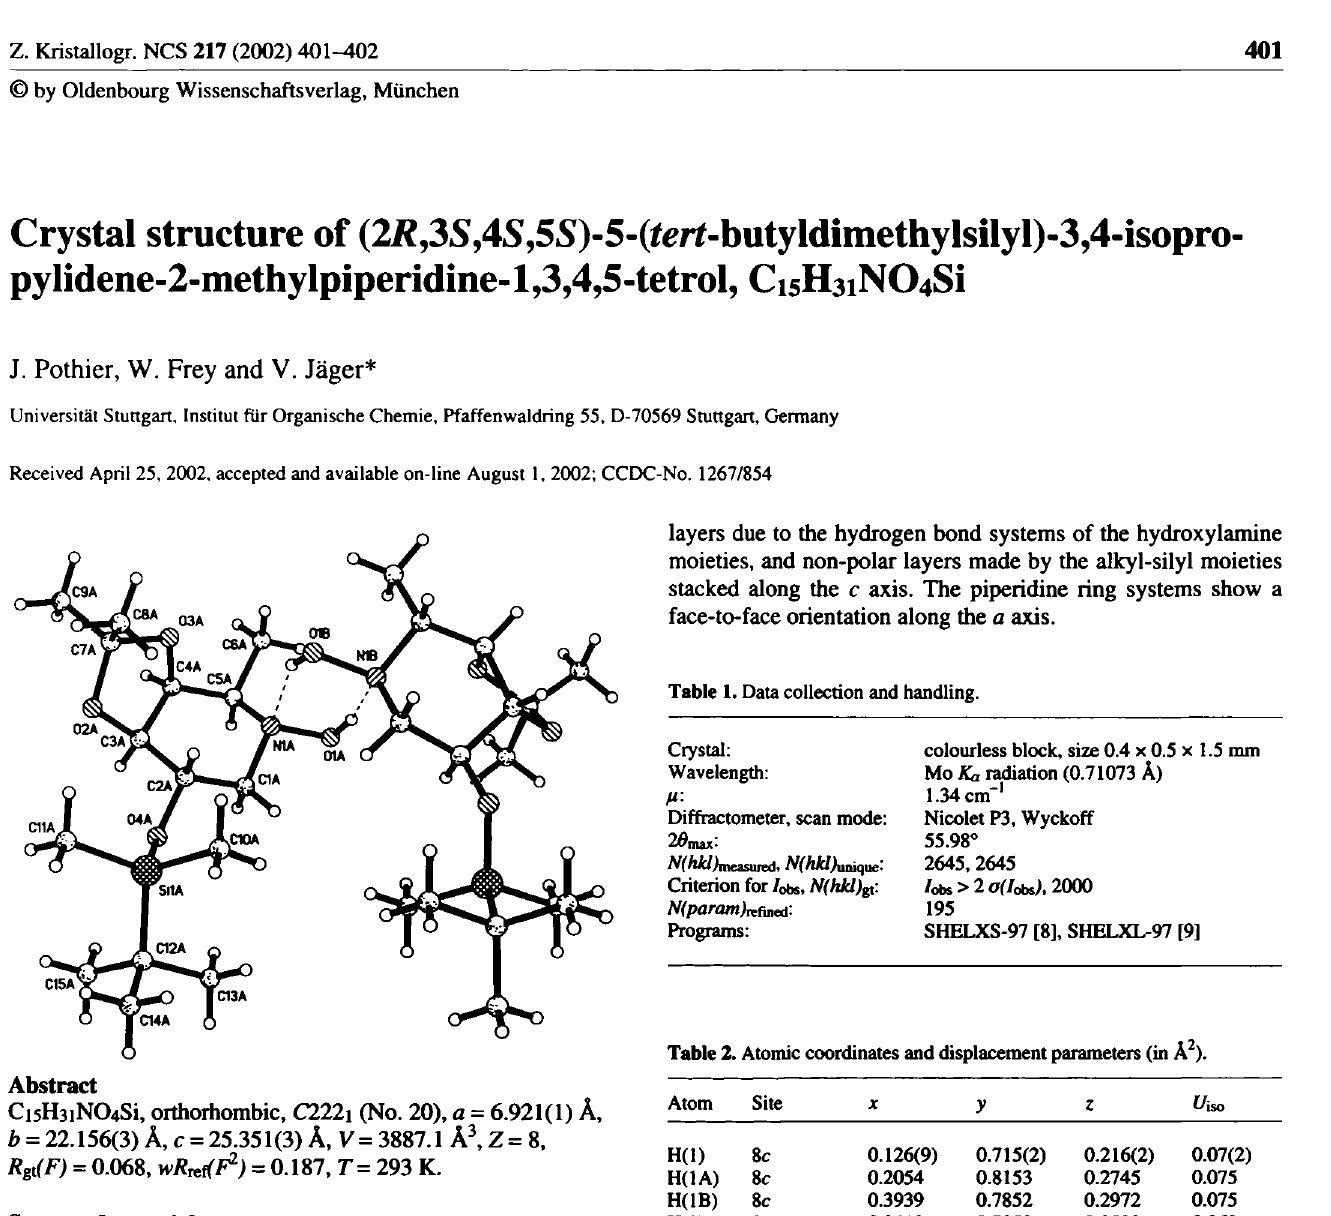
Table 2. Atomic coordinates and displacement parameters (in Â 2